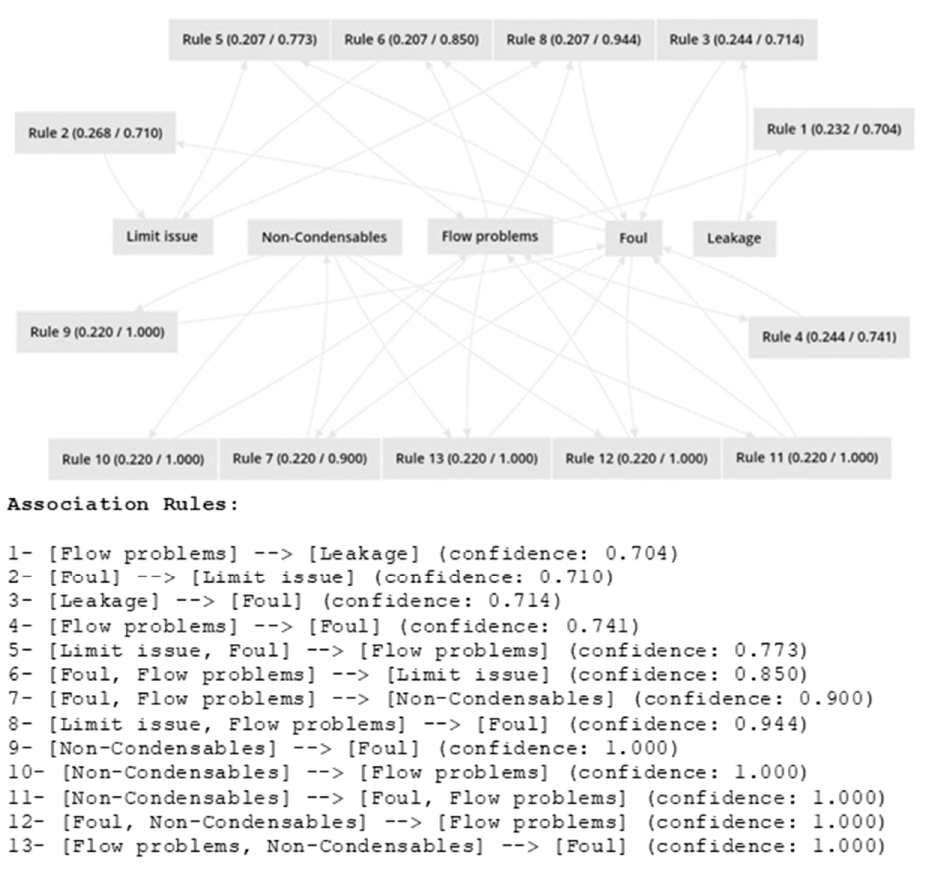
Figure 7. Association rules for the co-occurrence of common HVAC faults for the literature analyzed.